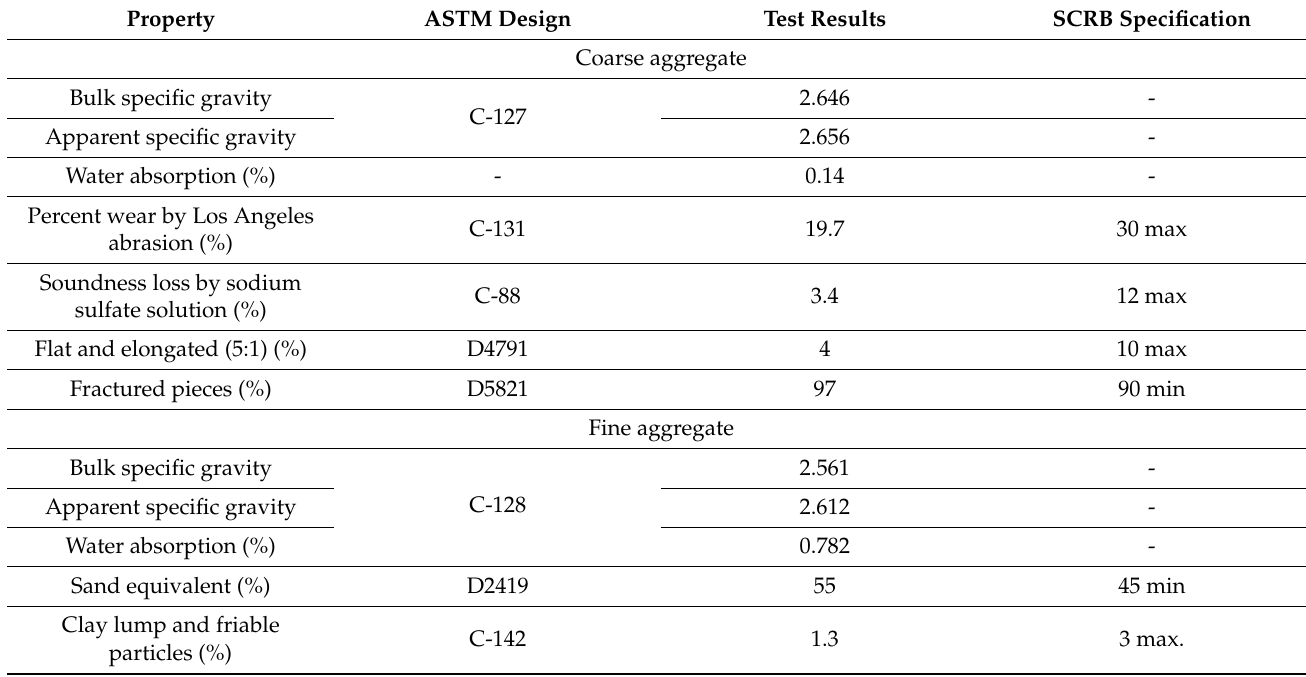
Table 2. Physical properties of aggregates.